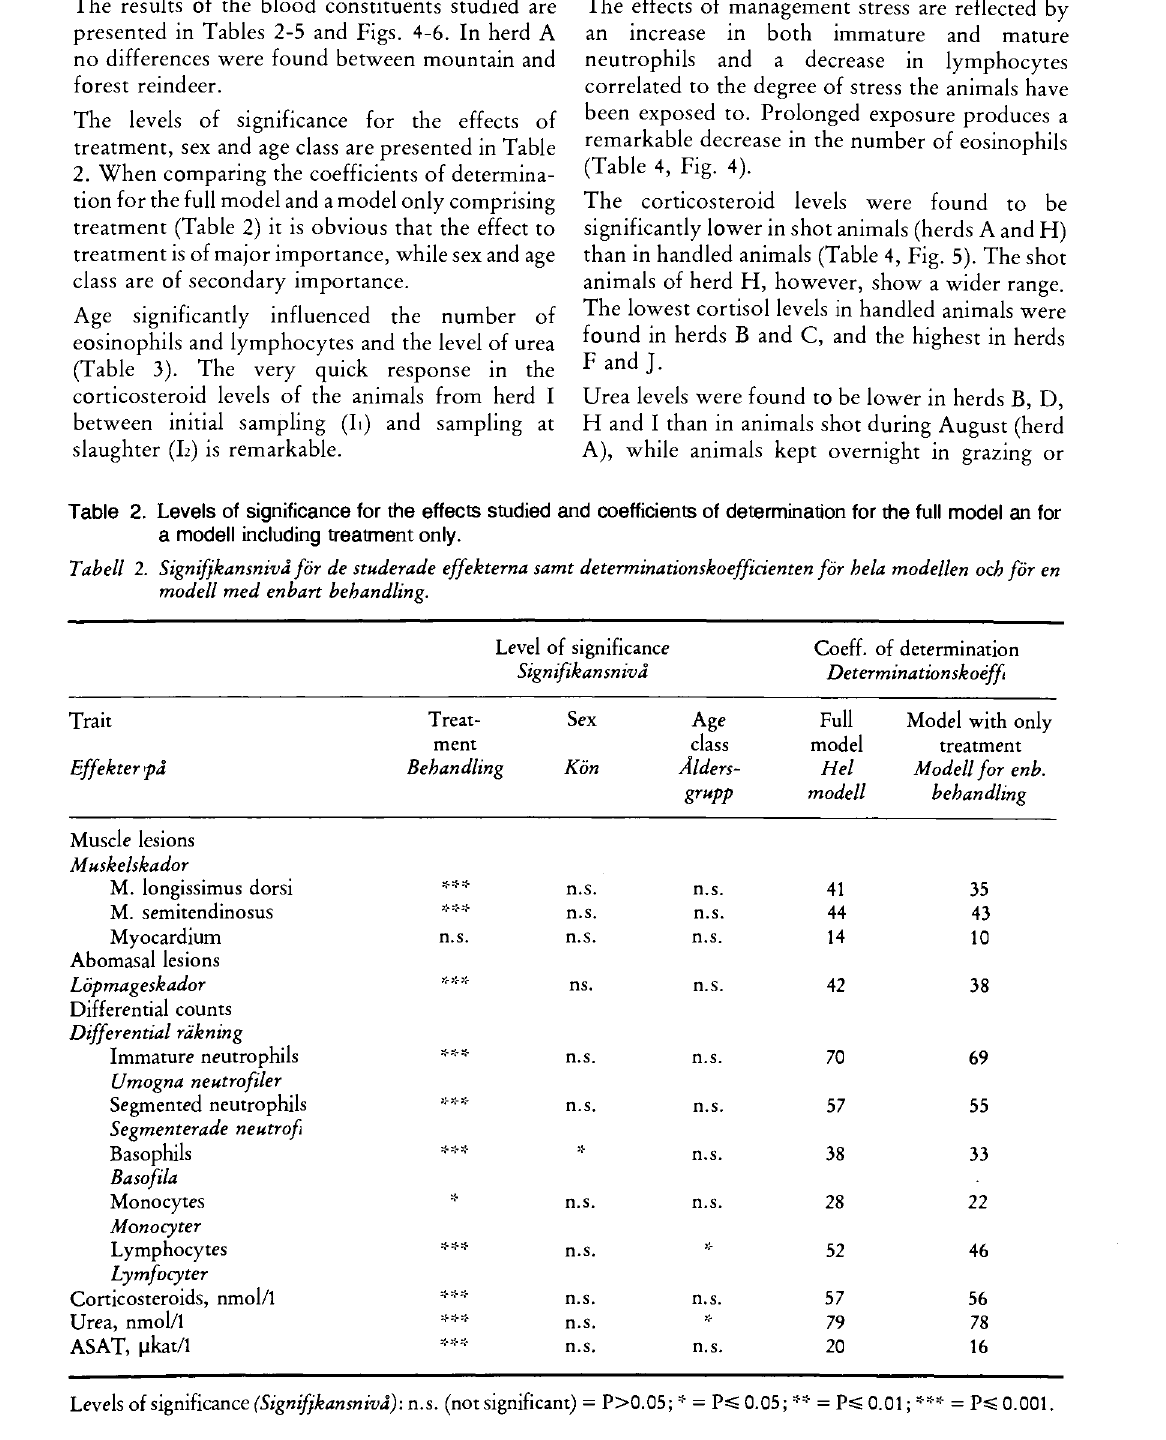
Table 2. Levels of significance for the effects studied and coefficients of determination for the full model an for a modell including treatment